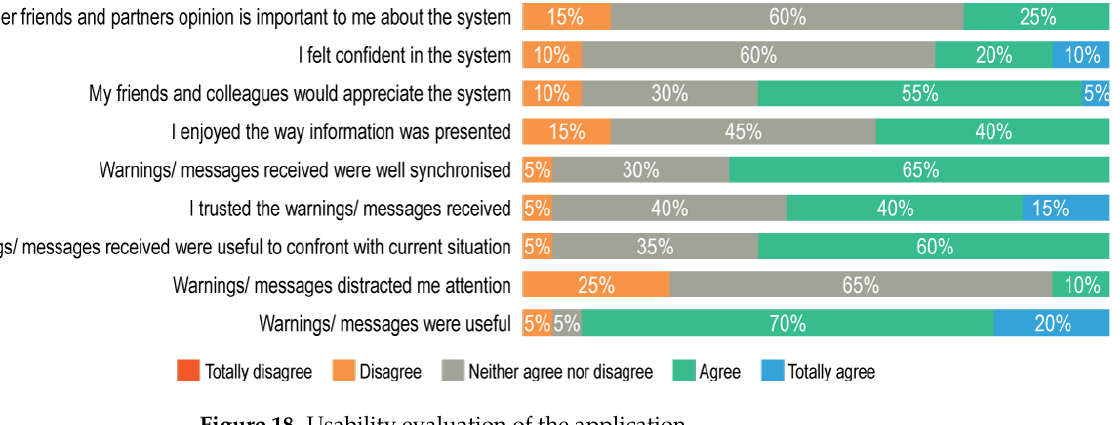
Figure 18. Usability evaluation of the application.